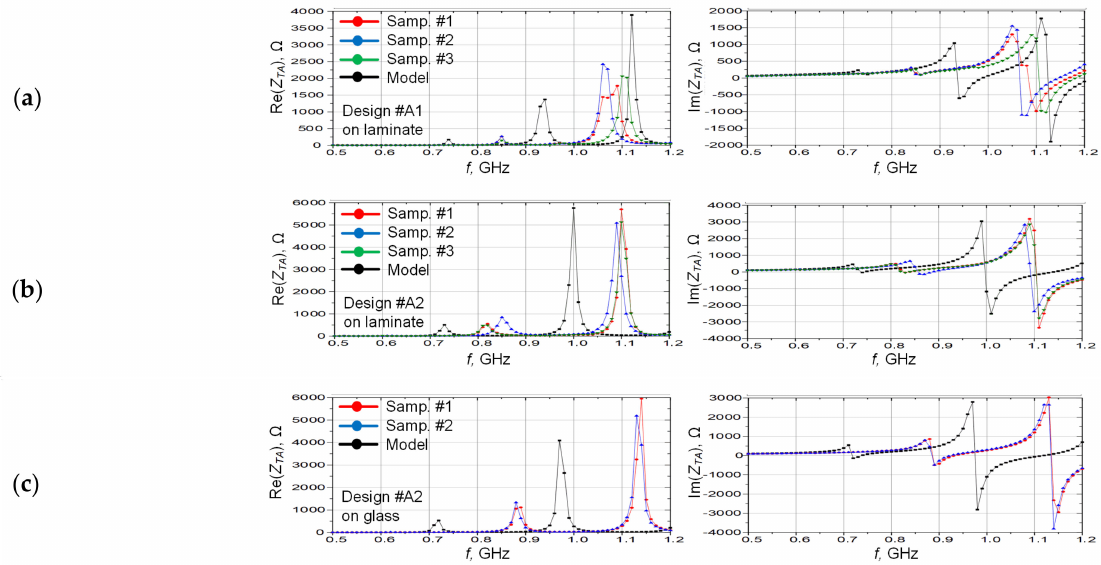
Figure 6. Impedance of RFID antenna: ( a ) Design #A1 on low-iron laminate; ( b ) Design #A2 on low-iron laminate; ( c ) Design #A2 on low-iron